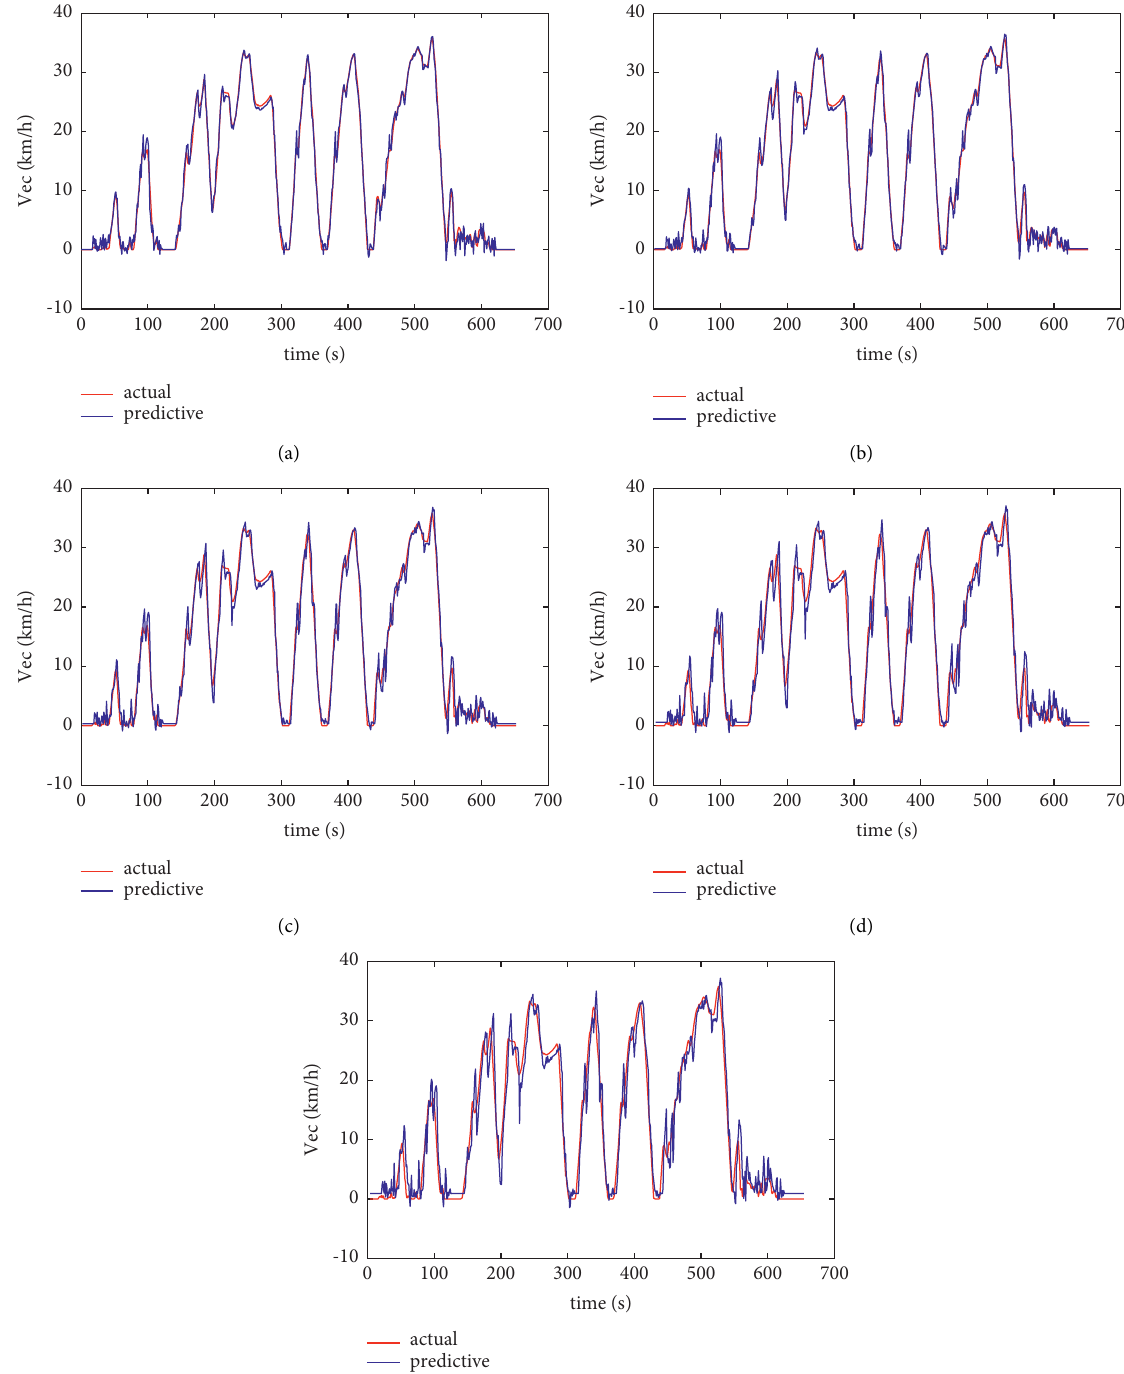
Figure 13: Comparison between predictive results and actual results. (a) Predictive velocity in 1st second. (b) Predictive velocity in 2nd second. (c) Predictive velocity in 3rd second. (d) Predictive velocity in 4th second. (e) Predictive velocity in 5th